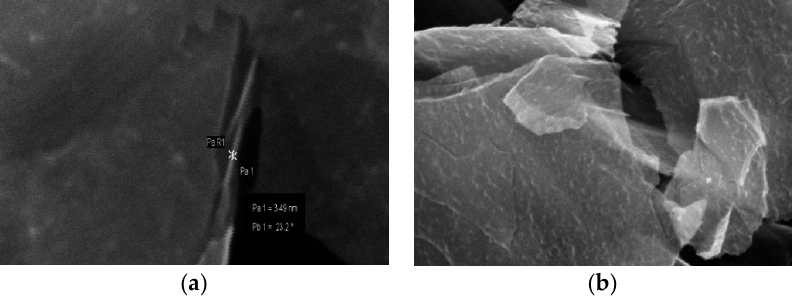
Figure 4. SEM images of xGnP ( a ) and ox-xGnP ( b ) .